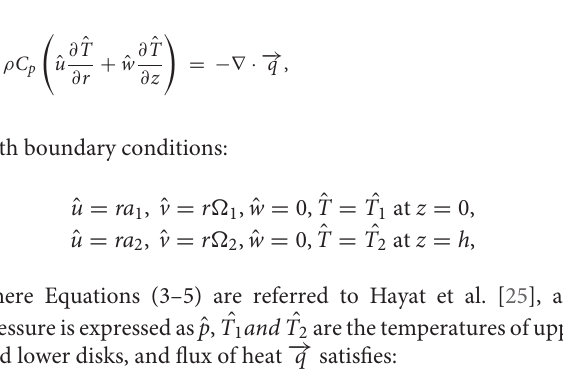
FIGURE 4 | Behavior of f ′ ( ξ ) for different Re